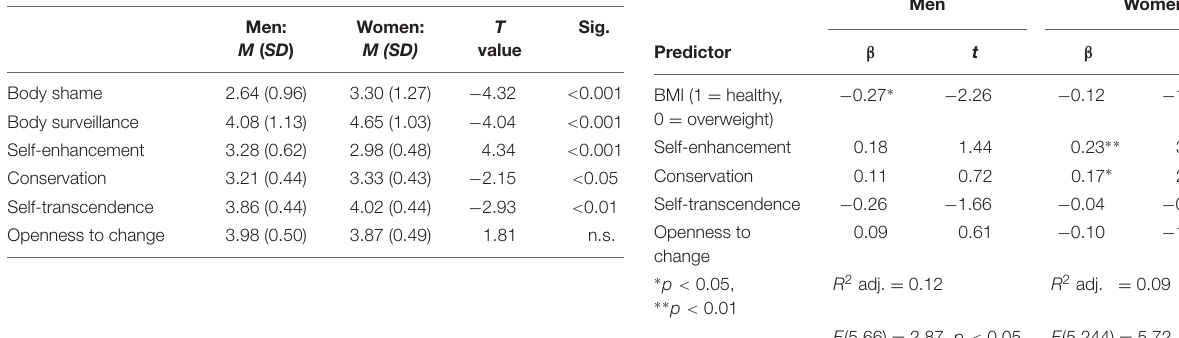
TABLE 2 | Differences between men and women on self-objectification and personal values.